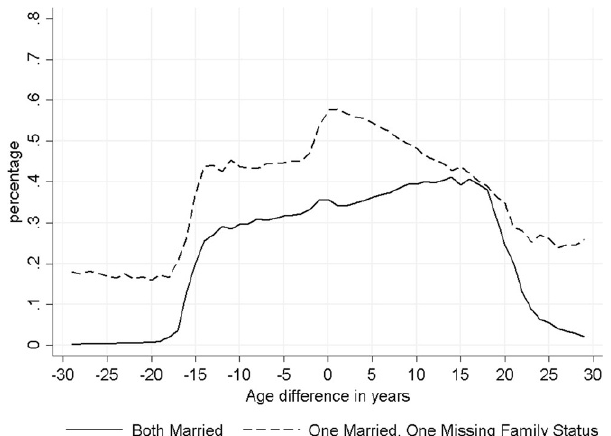
Fig. 5 Share of matched pairs listed as married-married or married- missing. (Note: Includes all male-female pairs of individuals who we were able to match by location and name (according to our name- matching algorithm), and where at least one member has the family status variable filled in. Age difference is calculated as man’s age – wife’s